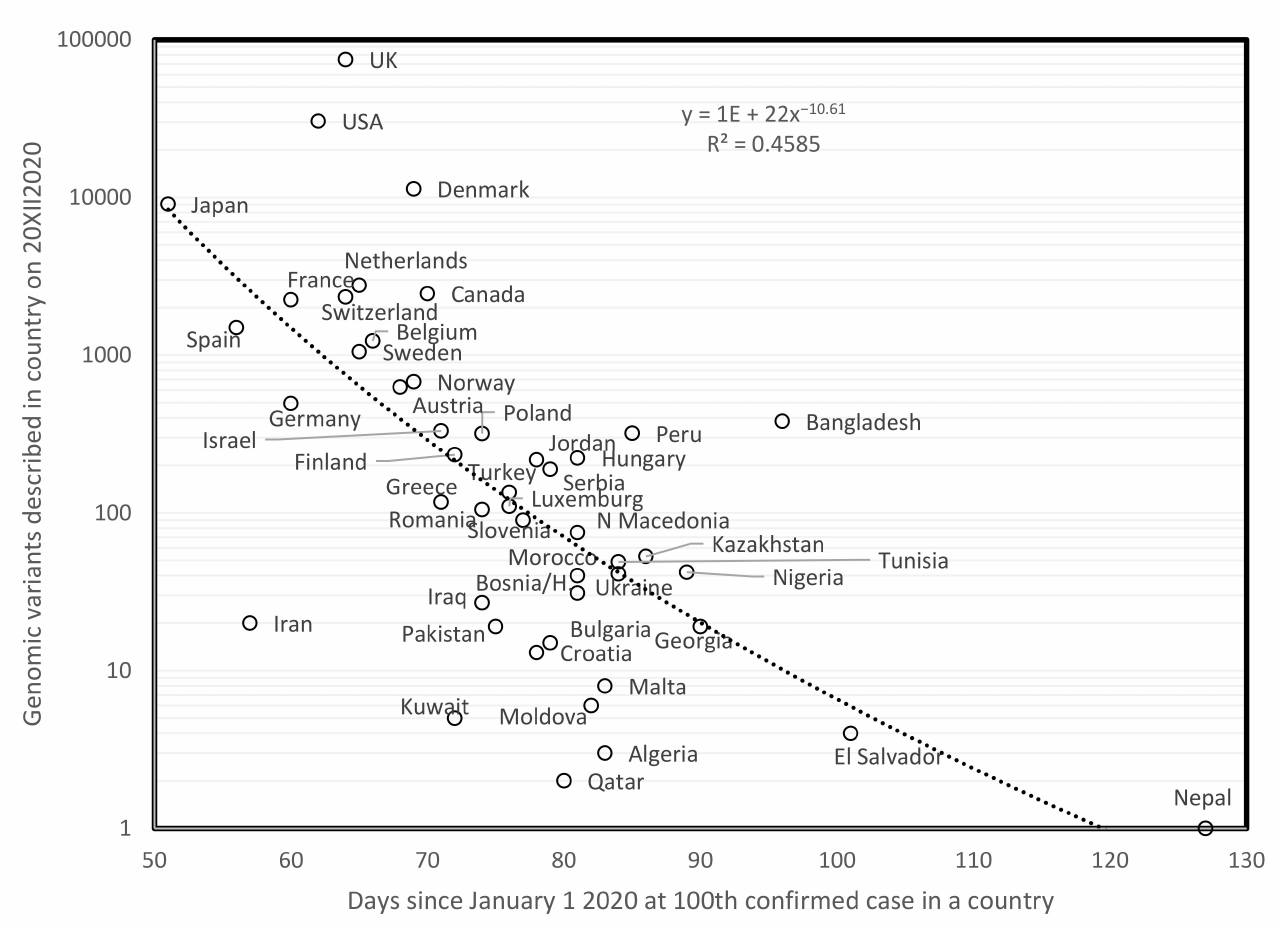
Figure 1. Numbers of genomic variants of SARS-COVID-19 as a function of days since 1 January 2020 until 100 confirmed cases were detected in a